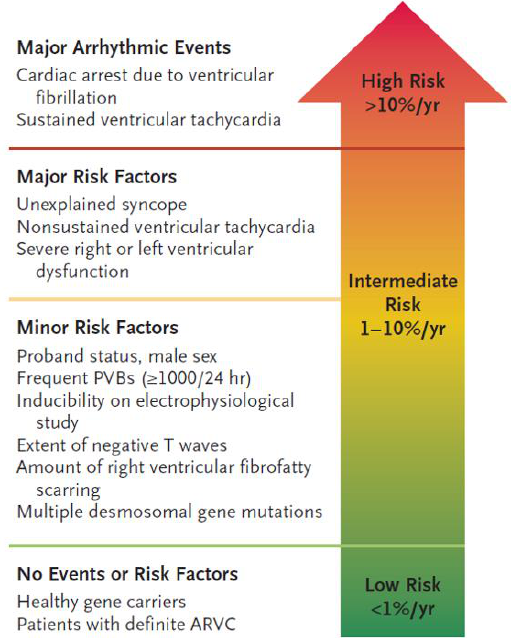
Figure 3. Risk stratification in patients affected by ACM. Risk of major arrhythmic events is based on previous events and specific risk factors. ACM= arrhythmogenic cardiomyopathy. From The New England Journal of Medicine, Domenico Corrado, Mark S. Link, Hugh Calkins, Arrhythmogenic Right Ventricular Cardiomyopathy. New Engl. J. Med. 2017, 376, 61–72. Copyright © 2021 Massachusetts Medical Society. Reprinted with permission [44].